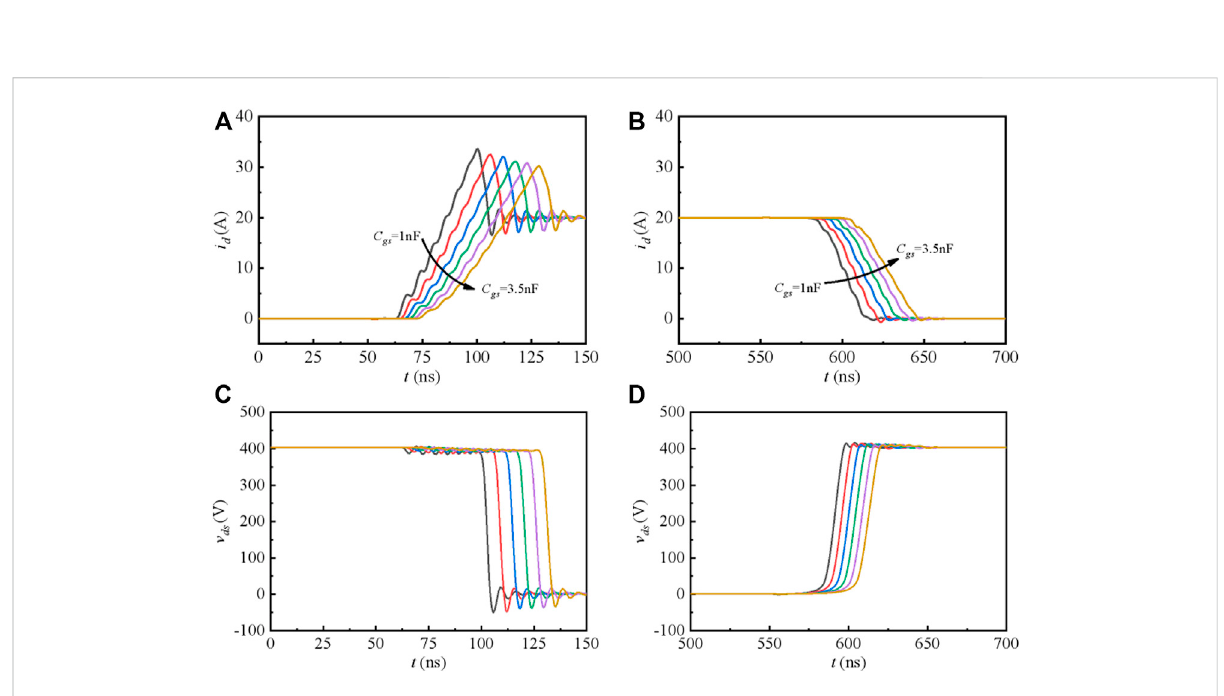
FIGURE 6 In fl uence of C gs on the switching behavior of the SiC MOSFET. (A) Turn-on i d . (B) Turn-off i d . (C) Turn-on u ds . (D) Turn-off u ds